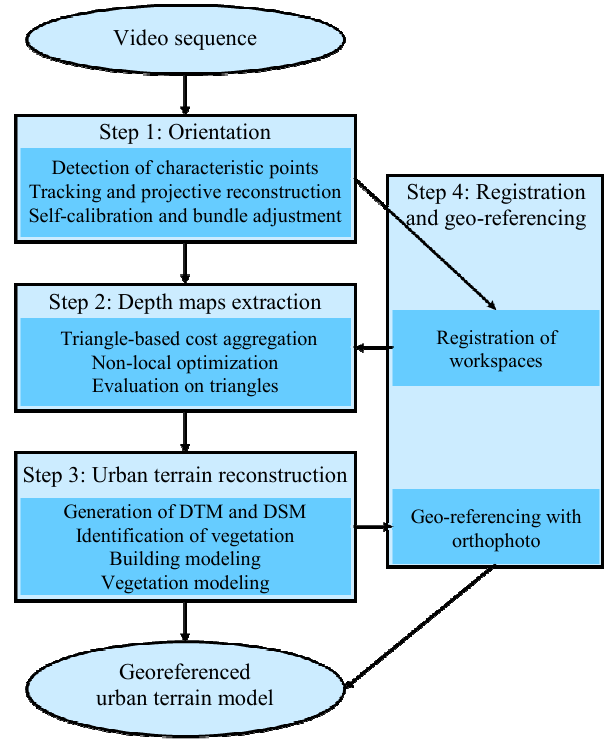
Figure 1: Overview of the